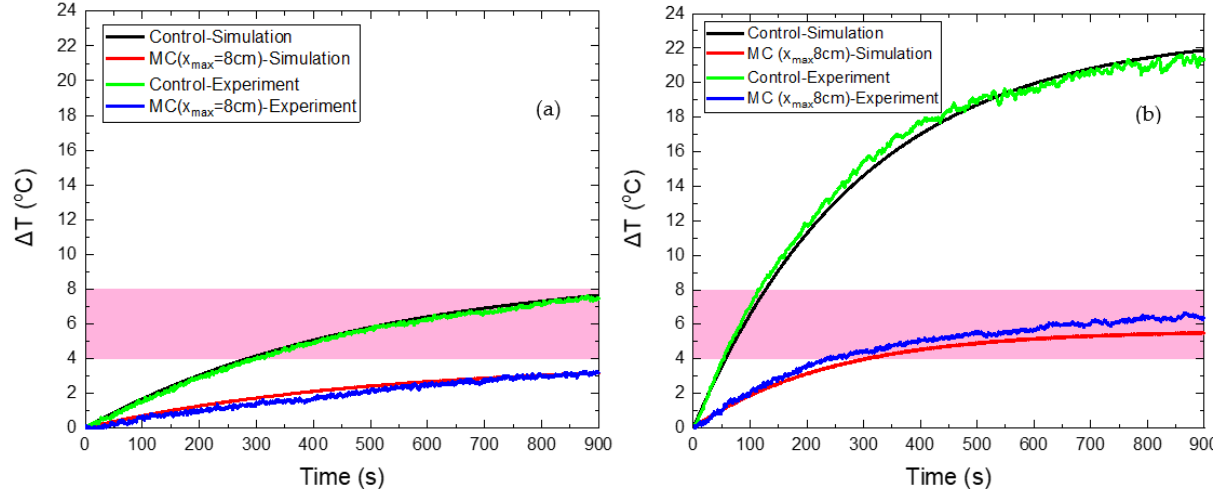
Figure 10. Temperature increase of HTP ( a ) and CTP ( b ) samples for a stationary coil, denoted as the control case (black color corresponds to numerical curve and green color to the experimental one) and for moving coil (red color corresponds to numerical curve and blue color to the experimental one).